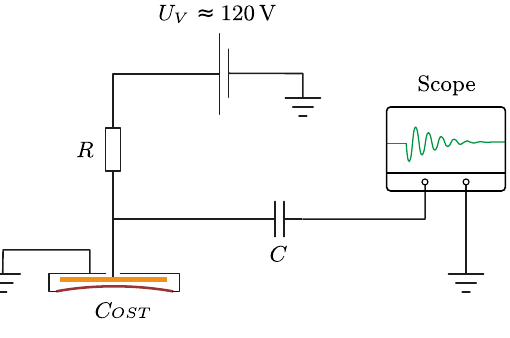
FIG. 7. Readout circuit for the